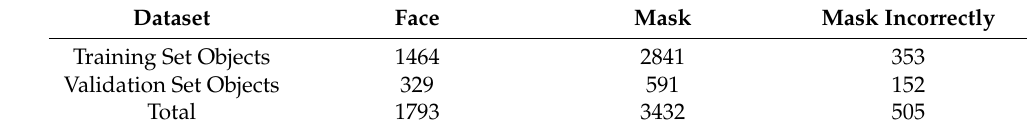
the centroids, and (c) represents the distribution of object sizes, with the horizontal and vertical coordinates indicating the width and height of the objects.